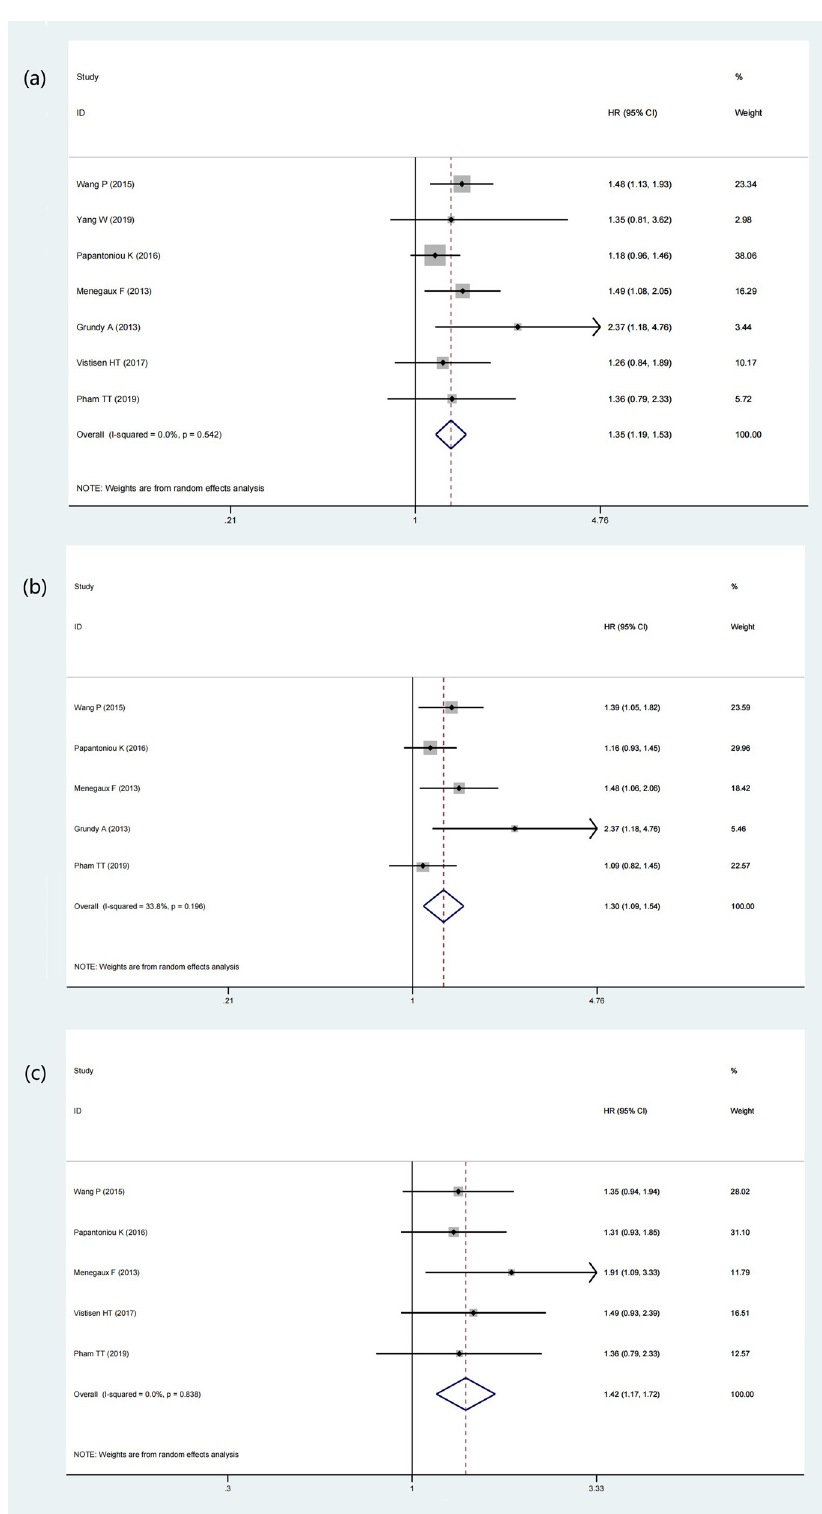
Figure 5: Forest plot depicting the association between night shift work and risk of receptor positive BC. ( a ) ER + BC. ( b ) ER + BC. ( c ) HER2 +